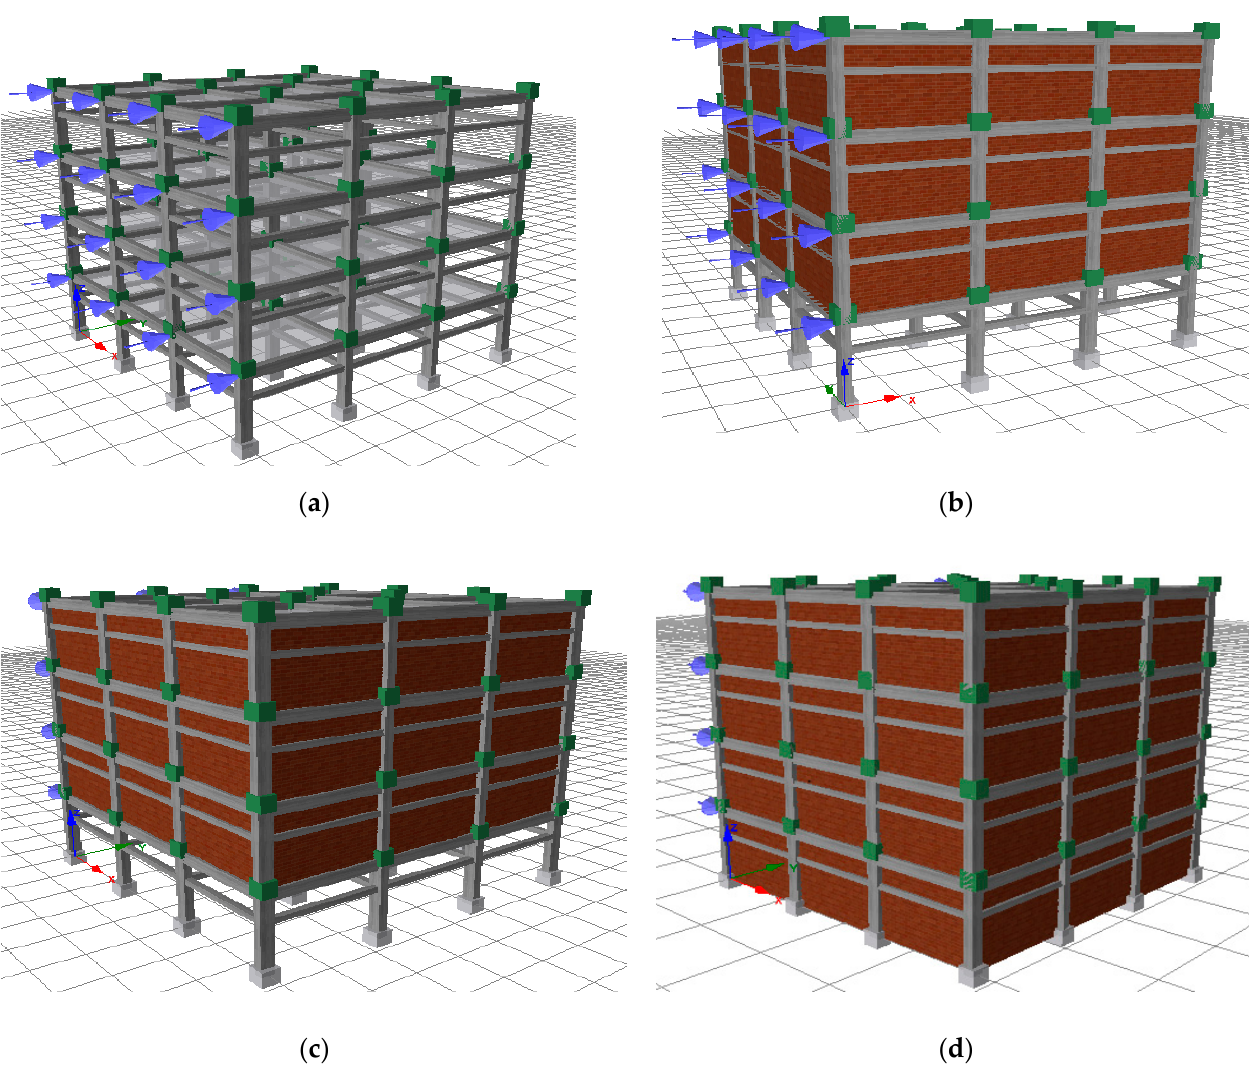
Figure 4. Three-dimensional (3D) finite element models of the case study building: ( a ) bare frame with lintel beam; ( b ) open ground reinforced concrete (RC)-URM infill with lintel beam; ( c ) open ground RC-SIM infill with lintel beam; ( d ) full RC-URM infill with lintel beam.